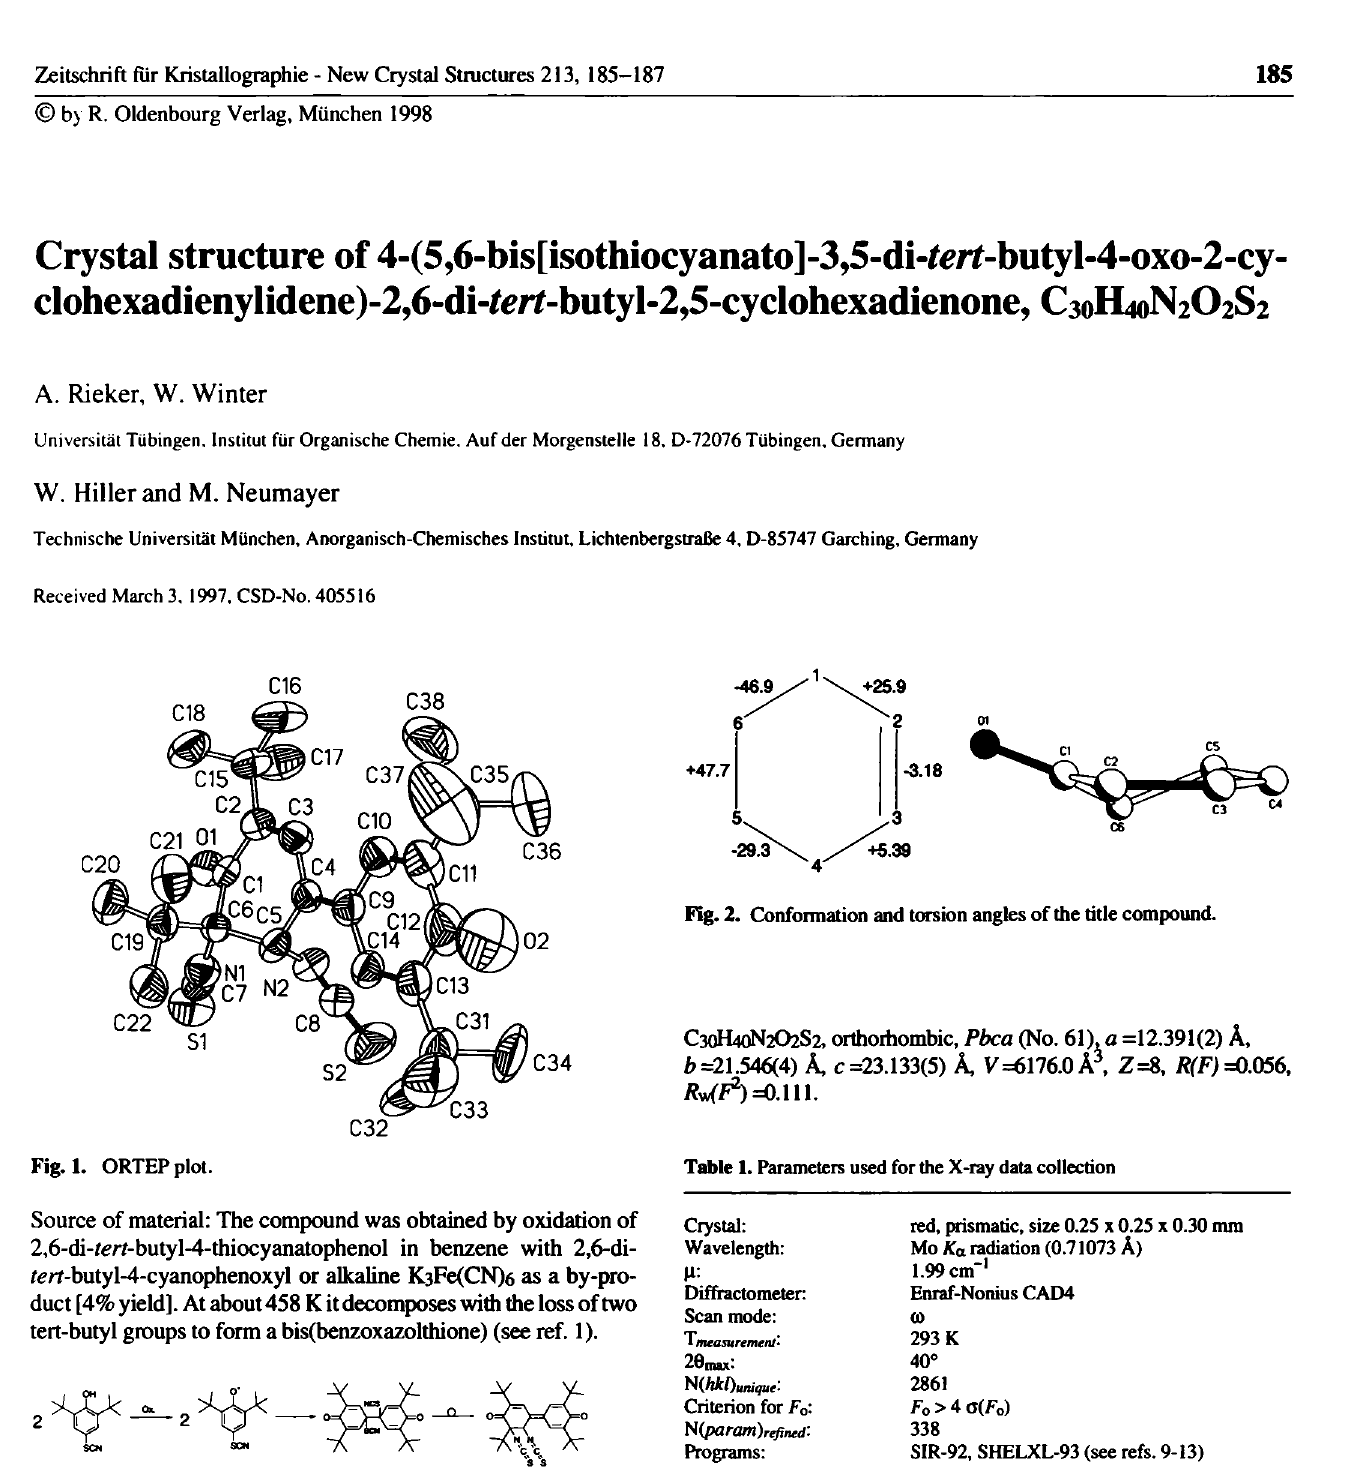
Table 2. Final atomic coordinates and displacement parameters (in